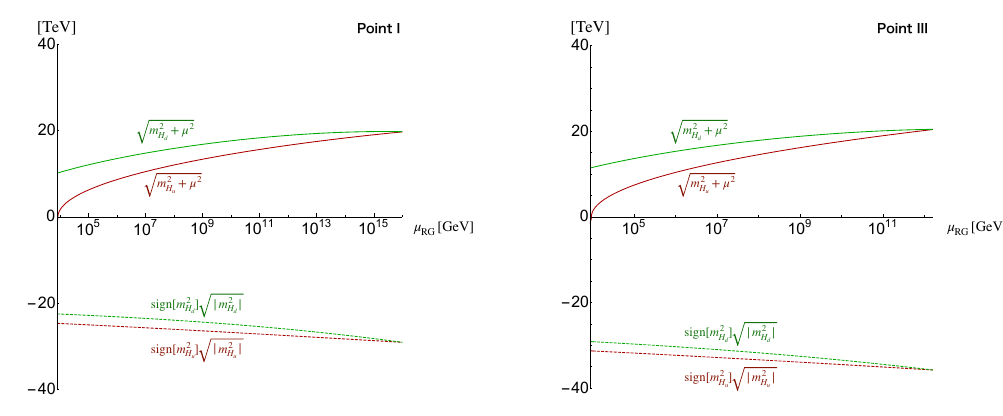
q q q q j m 2 + (cid:22) 2 j and j m 2 + (cid:22) 2 j ( j m 2 j and j m 2 j ), respectively, H u H d H u H d